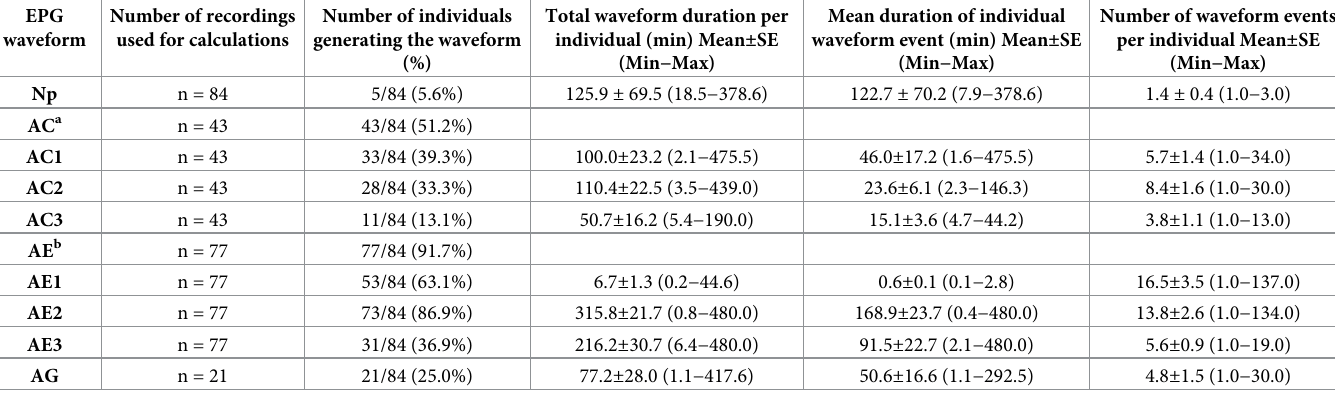
Table 2. Frequency and duration of individual EPG-recorded waveforms generated by Adelges laricis during probing on Larix decidua . EPG Number of recordings waveform used for calculations